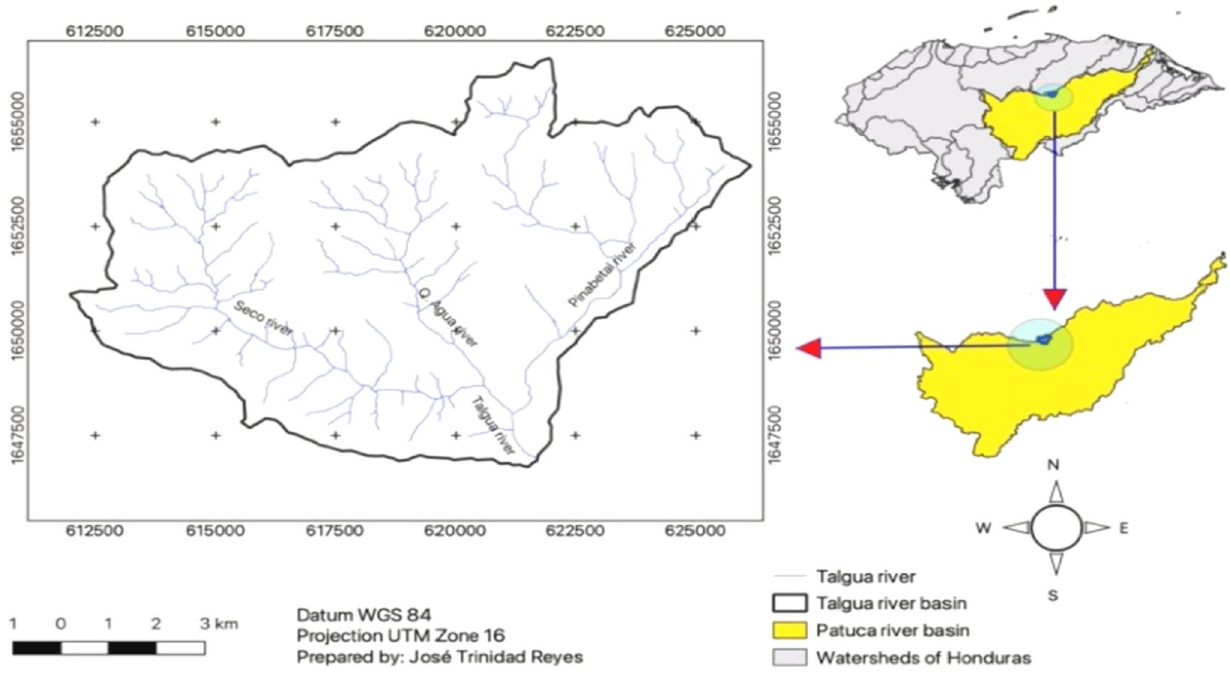
Fig. 1 Geographical location of the Talgua river basin,